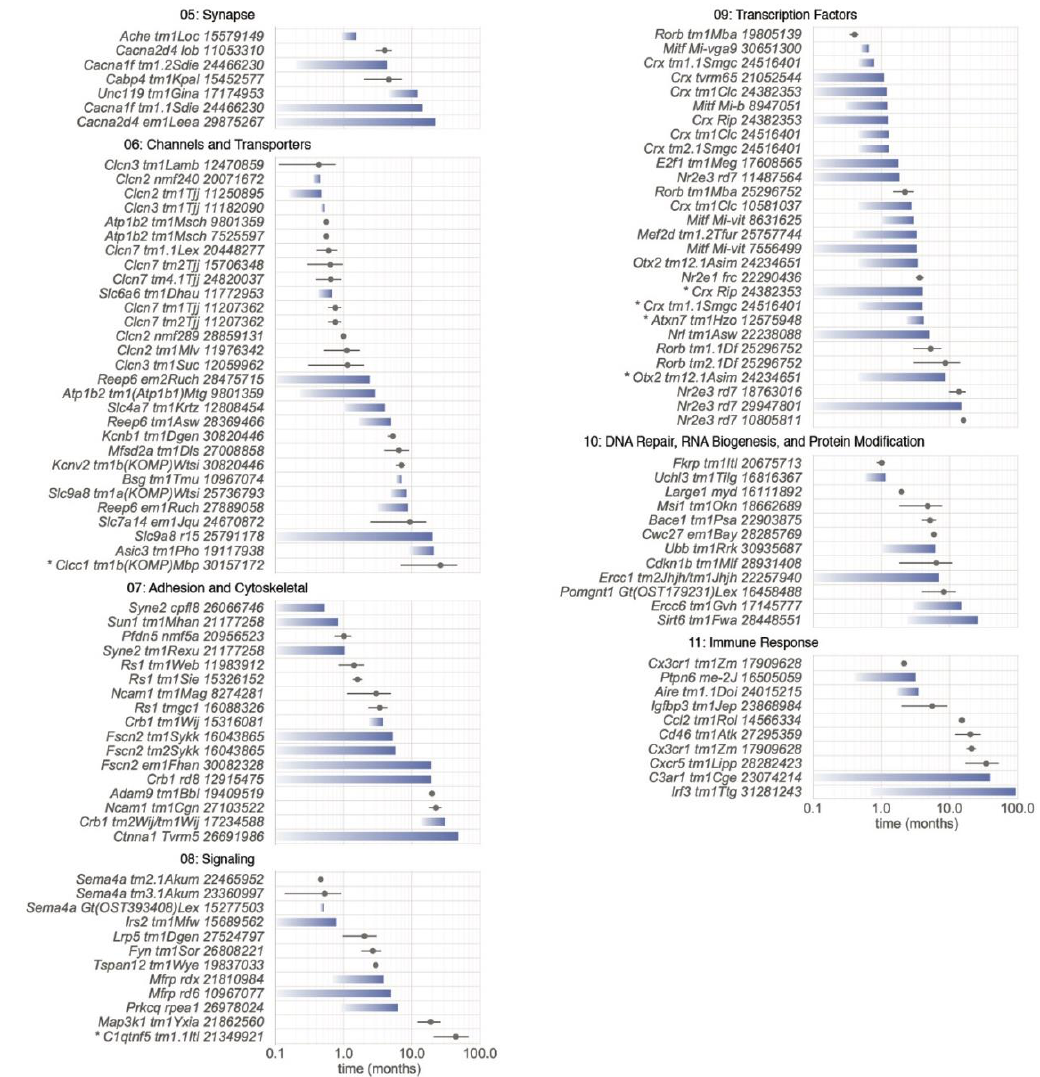
Figure 6. Progression of PR cell loss in mouse models by functional category. Models in each category were sorted by the age at which the estimated number of PR cells reached 50% of wild-type (D 50 ) as determined by fitting reported data to an exponential decay function combined with a delay. Models are identified by gene symbol, MGI allele symbol, and PMID. Models are homozygous except as indicated by * (heterozygous) or by the presence of two allele symbols (compound heterozygous). Left- and right-hand margins of shaded bars represent the delay and D 50 values, respectively. Bars with a delay value of ≤ 0.1 month derive from datasets in which no values at 100% of wild type were reported. The midpoint and range of estimated D 50 values for datasets with only one point in the 5–95% range is indicated by closed circles and range lines, respectively. In cases where the dataset consisted of a single point at 50%, no estimate was needed.